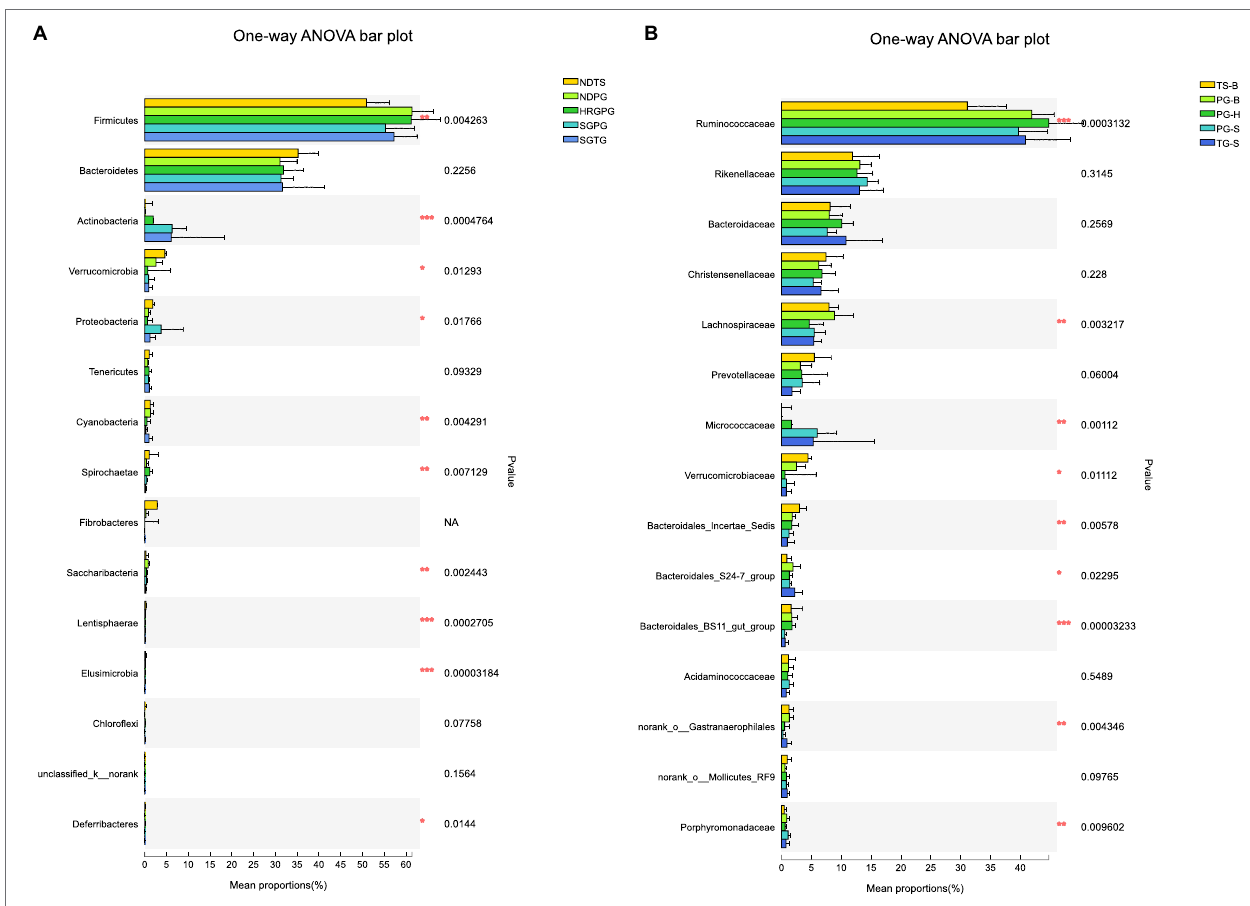
FIGURE 7 | (A) Phyla differences among the Przewalski’s gazelle from Haergai (PG-H), Bird Island (PG-B), Shengge Township (PG-S), Tibetan gazelle from Shengge Township (TG-S), and Tibetan sheep from Bird Island (TS-B). (B) Family differences among the Przewalski’s gazelle from Haergai (PG-H), Bird Island (PG-B), Shengge Township (PG-S), Tibetan gazelle from Shengge Township (TG-S), and Tibetan sheep from Bird Island